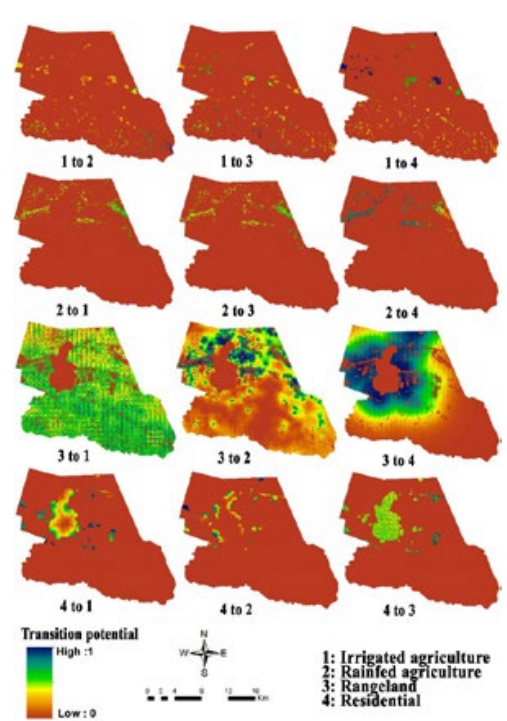
Fig. 4: Transition potential maps for different land uses generated through MLP